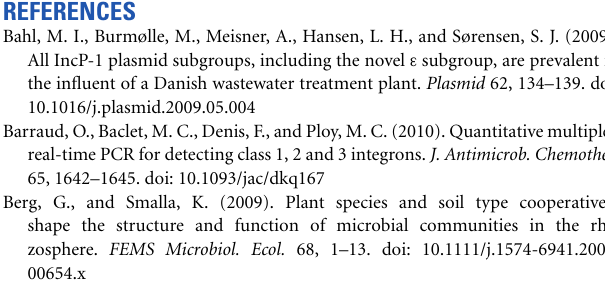
Figure S1 | PCR amplification from total community DNA and subsequent Southern blot hybridization of class 1 integron integrase gene intI1 . Figure S2 | PCR amplification from total community DNA and subsequent Southern blot hybridization of quaternary ammonium compound resistance gene qacE . Figure S3 | PCR amplification from total community DNA and subsequent Southern blot hybridization of quaternary ammonium compound resistance gene qacE (cid:2) 1 . Figure S4 | PCR amplification from total community DNA and subsequent Southern blot hybridization of class 1 integron integrase gene intI1 . Figure S5 | PCR amplification from total community DNA and subsequent Southern blot hybridization of quaternary ammonium compound resistance gene qacE (cid:2) 1